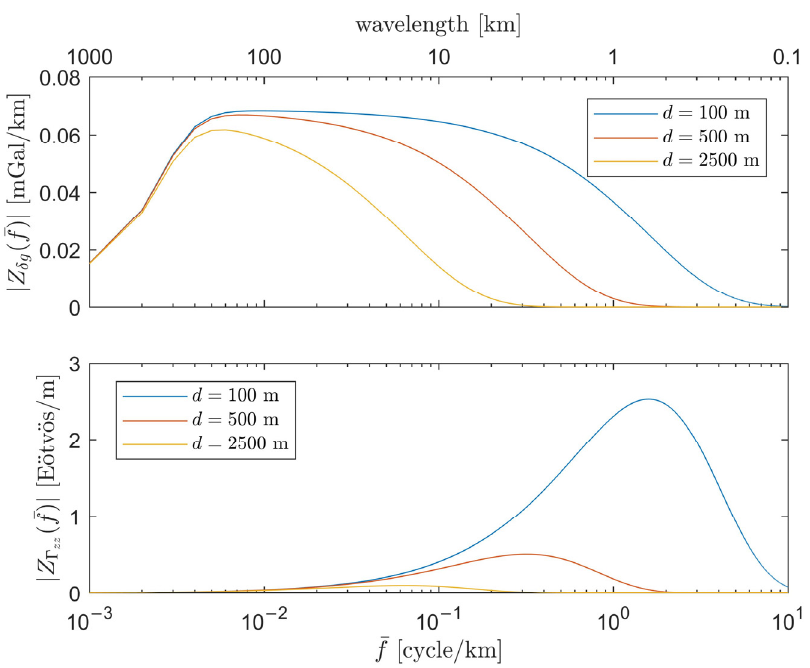
Figure 2. The theoretical gravitational admittance ( top ) and gravity gradient admittance ( bottom ) with respect to mean sea depth 𝑑 .